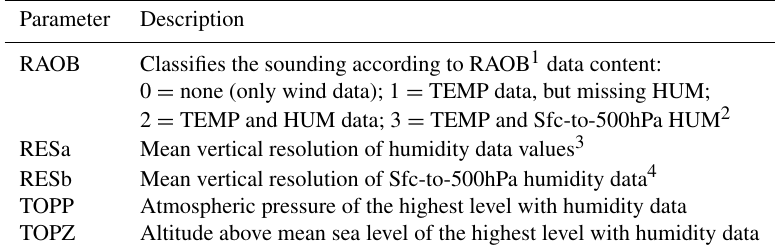
Table 3. Parameters of humidity completeness for each sounding.